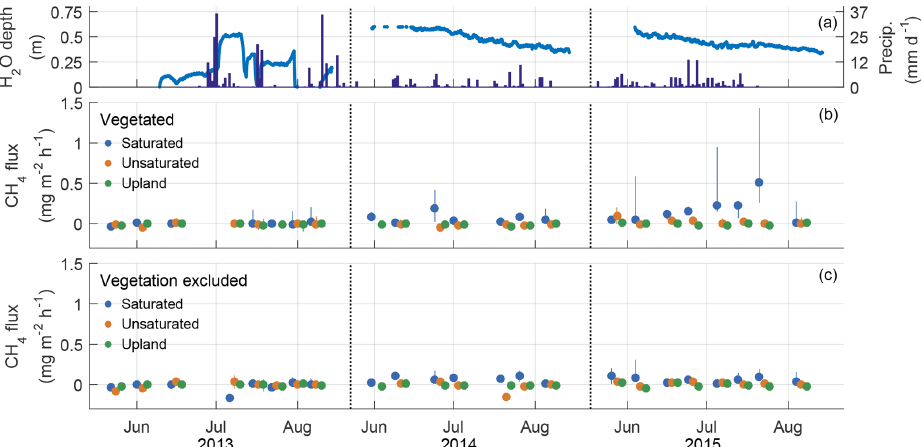
Figure 3. Water table, precipitation, and median CH 4 fluxes by sampling date. Water table depth and precipitation (a) were measured at the central meteorological station (Fig. 1). Circles indicate median CH 4 flux on the day of sampling, and lines indicate the 25th to 75th percentiles for collars with vegetation (b) and collars maintained free of vegetation (c) . An offset between vegetation groups has been added to the x axis to reduce overlapping points. All groups were sampled on the same day, roughly once a week. Tick marks on the x axis indicate first day of the labelled month. If the upper 75th percentile exceeded the range of the y axis, the value is printed on the plot. Table 2. Spearman rank correlations to assess temporal trends in net ion adsorption rates for the three plot groups. Plant root simulator (PRS) data were categorized into chronological order (1–9 for the three burial periods over 3 years, “Combined”), seasonal order regardless of year (1–3, “Seasonal”), and annual order regardless of season (1–3, “Annual”). Bold values indicate a significant trend at α = 0 . 01. The greatest temporal trend across all plot groups for a given ion and depth is in italic. Ion Lowland saturated Lowland unsaturated Upland Combined Seasonal Annual Combined Seasonal Annual Combined Seasonal Annual